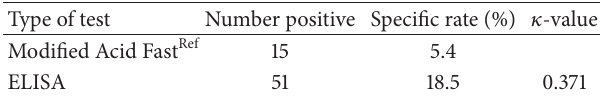
Table 1: Level of agreement between MAF and ELISA using Kappa’s